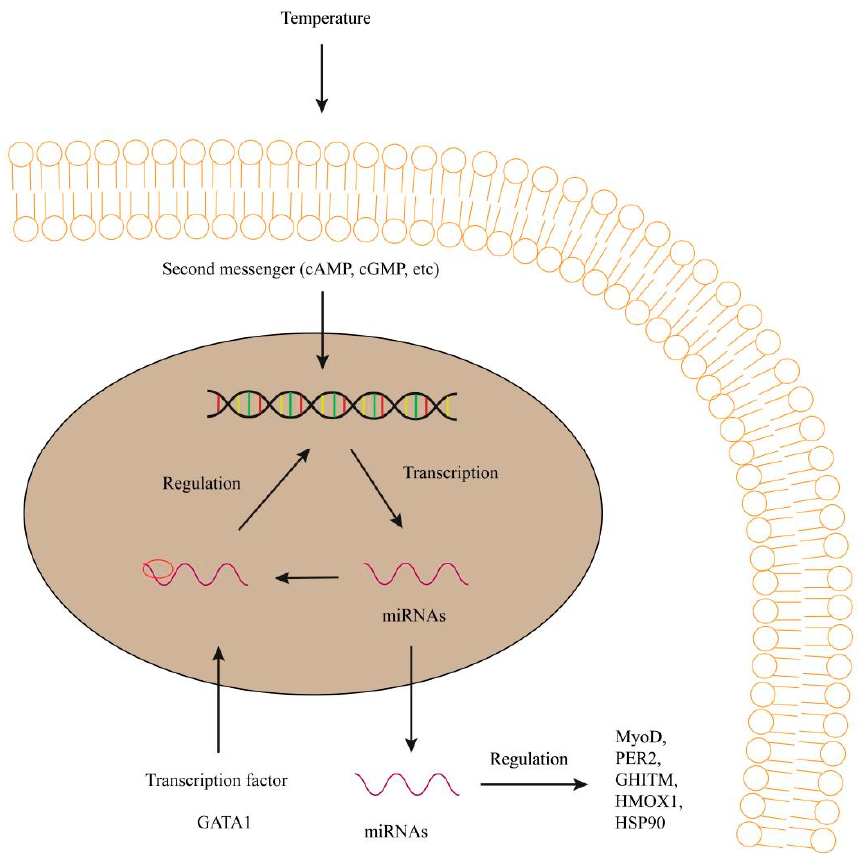
Figure 2. Regulation of GATA1, MyoD, PER2, GHITM, HMOX1 and HSP90 etc. by miRNAs under temperature in fish. miRNAs can negatively regulate the transcription of DNA induced by second messengers. miRNAs regulate gene expression and function in target genes. They regulate transcription of the target genes and protein synthesis. GATA1, mean GATA binding protein 1; MyoD, Myoblast determination protein; PER2, mean period circadian regulator 2; GHITM, mean growth hormone inducible transmembrane protein; HMOX1, mean heme oxygenase 1; HSP90, mean heat shock protein 90.